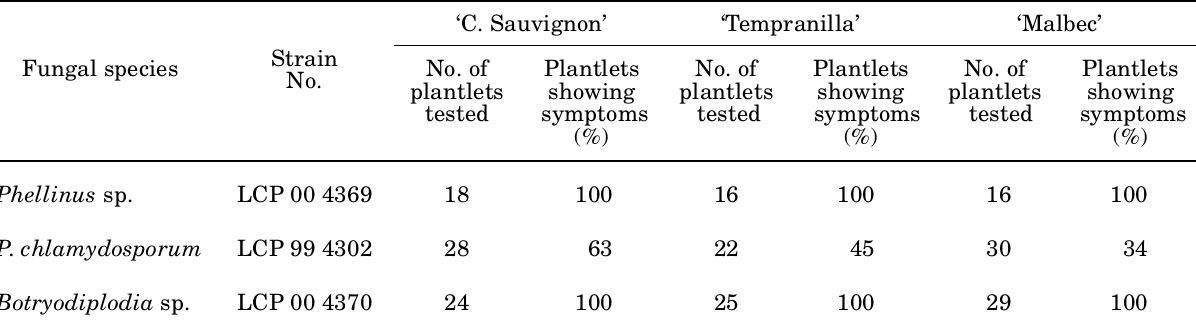
P. chlamydosporum LCP 99 4302 Botryodiplodia sp. LCP 00